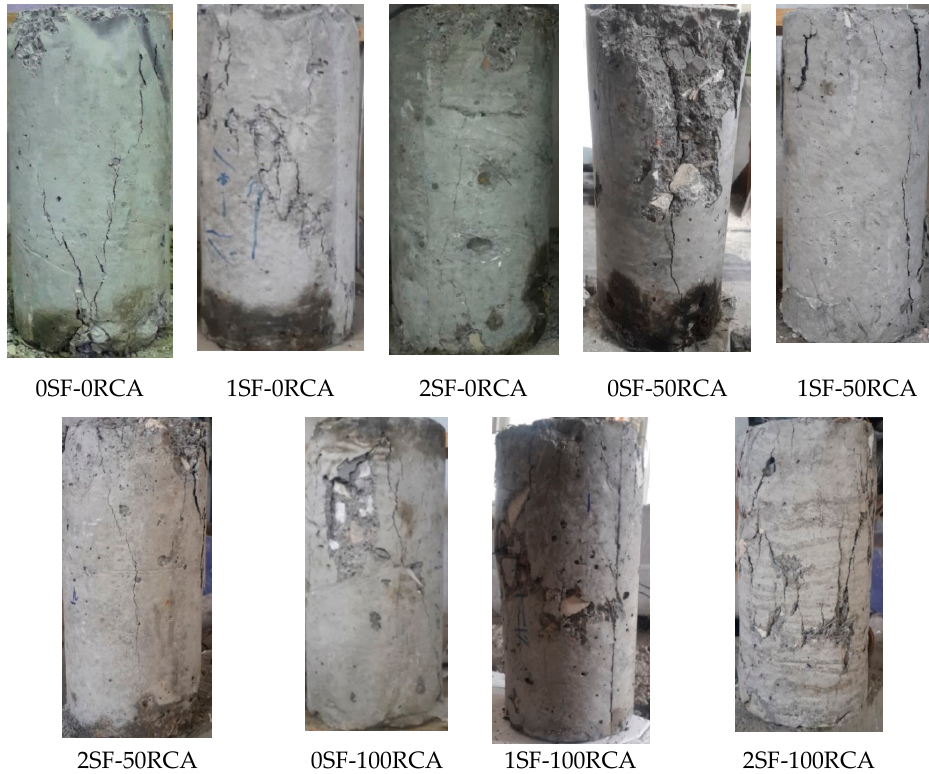
Figure 11. Effects of the SF and RCA contents on the concrete’s compressive behaviour. Figure 11. E ff ects of the SF and RCA contents on the concrete’s compressive behaviour.